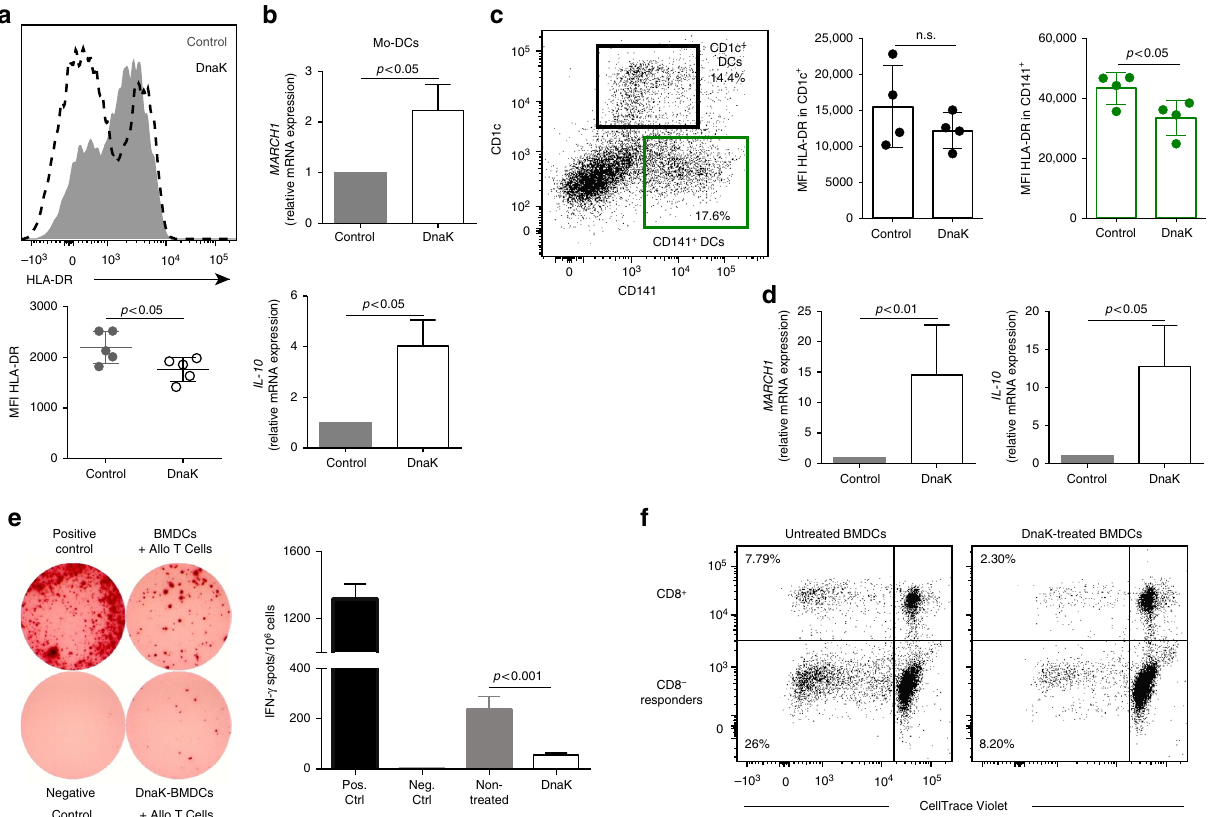
Fig. 7 DnaK reduces HLA-DR surface expression, induces MARCH1 and modulates allo-stimulatory capacity of human dendritic cells. a Representative histogram (upper) and mean fl uorescence intensity (MFI) quanti fi cation (lower) of HLA-DR expression in DnaK- or control-treated human monocyte- derived (Mo-DCs). Represented as mean ± SEM. * p < 0.05 when compared by Mann – Whitney. b Relative MARCH1 (upper) and IL-10 (lower) mRNA expression by DnaK-treated human Mo-DCs compared to non-treated cells. c Representative dot plot of human skin dermal DCs and HLA-DR MFI in CD141 + and CD1c + DCs treated with DnaK. d Relative MARCH1 (left) and IL-10 (right) mRNA expression by DnaK-treated human skin cells. For RT-PCR, GAPDH was used as internal control. Represented as mean ± SEM. Statistics using Mann – Whitney test. a – d n = 4 – 5 subjects. DnaK-treated or control BMDCs were assessed for their capacity to stimulate ( e ) IFN- γ and f proliferation of allogeneic PBMCs. e , f n = 3 subjects. Bar graphs represent the